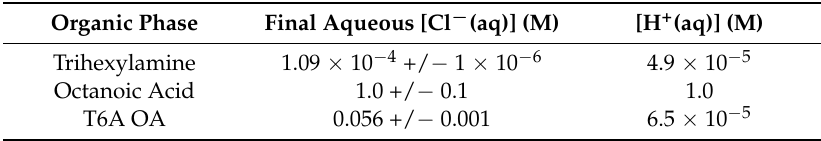
Table 4. Aqueous phase composition after extraction from acidic solution. Initial aqueous phase: 1.00M